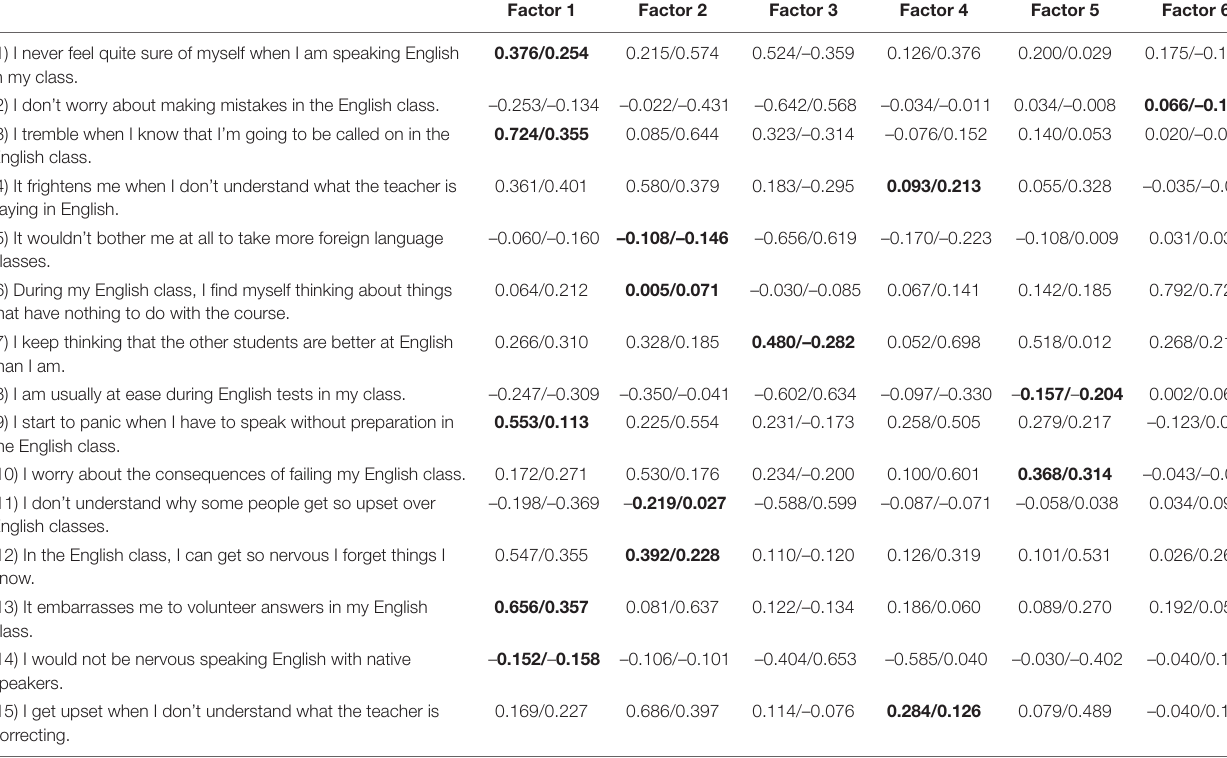
TABLE A2 | Loadings of principal components of FLCAS (phases 1/2) [Kaiser–Meyer–Olkin (KMO) = 0.942 in phase 1 and 0.921 in phase 2 ( p ≤